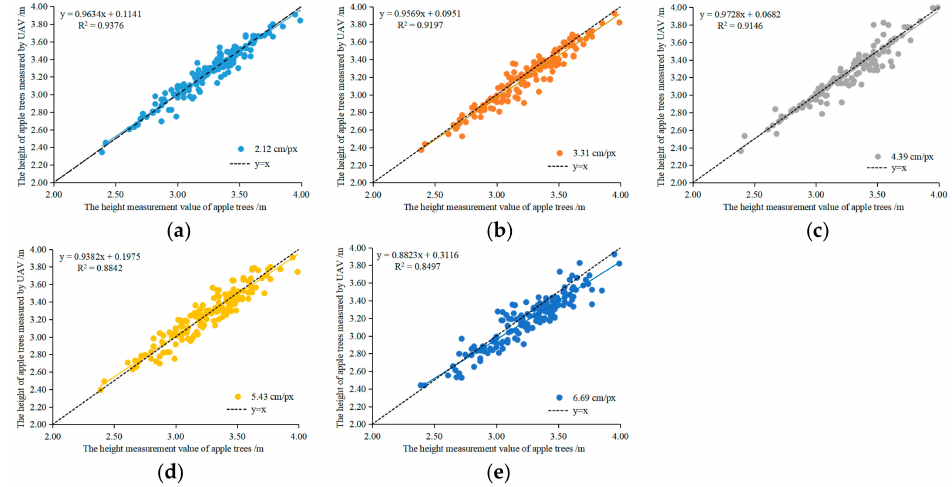
Figure 8. Canopy height values measured manually and estimated by UAV. ( a ) GSD = 2.12 cm / px; ( b ) GSD = 3.31 cm / px; ( c ) GSD = 4.39 cm / px; ( d ) GSD = 5.43 cm / px, GSD = 6.69 cm /